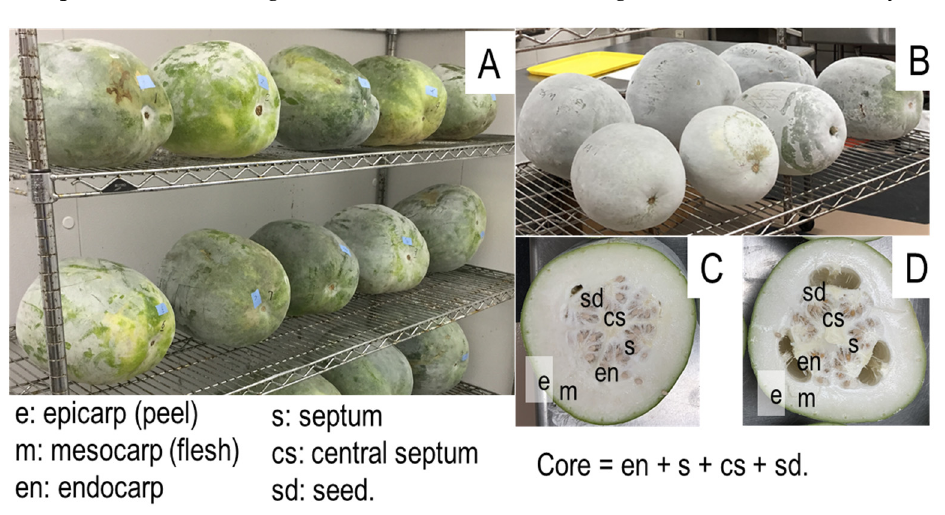
Figure 1. Surface waxy coat and internal structure of winter melon fruit at harvest and after 120 d storage at 20 °C. ( A ): Fruit, at harvest, covered with different levels of waxy coating; ( B ): Fruit, after 120 d storage at 20 °C, fully covered with thick waxy coating; ( C , D ): Transverse section of fruit at harvest ( C ) and after 120 d storage at 20 °C ( D ).